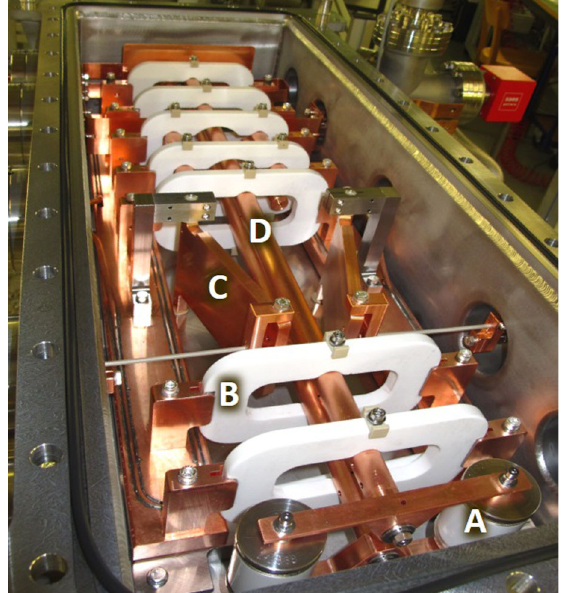
FIG. 13. Resonant kicker in the vacuum tank: A — vacuum capacitor (resonator capacitor), B — ceramic plate, C — tuning vane, and D — copper bar (resonator